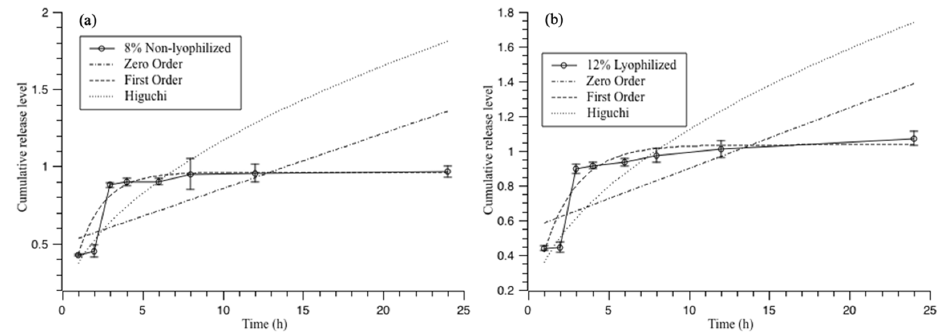
Figure 6. Release model fitting for a standard dissolution test (pH switching at the second hour): ( a ) 8% non-lyophilized CMC hydrogel under 504 nm; and ( b ) 12% lyophilized CMC hydrogel under 530 nm.